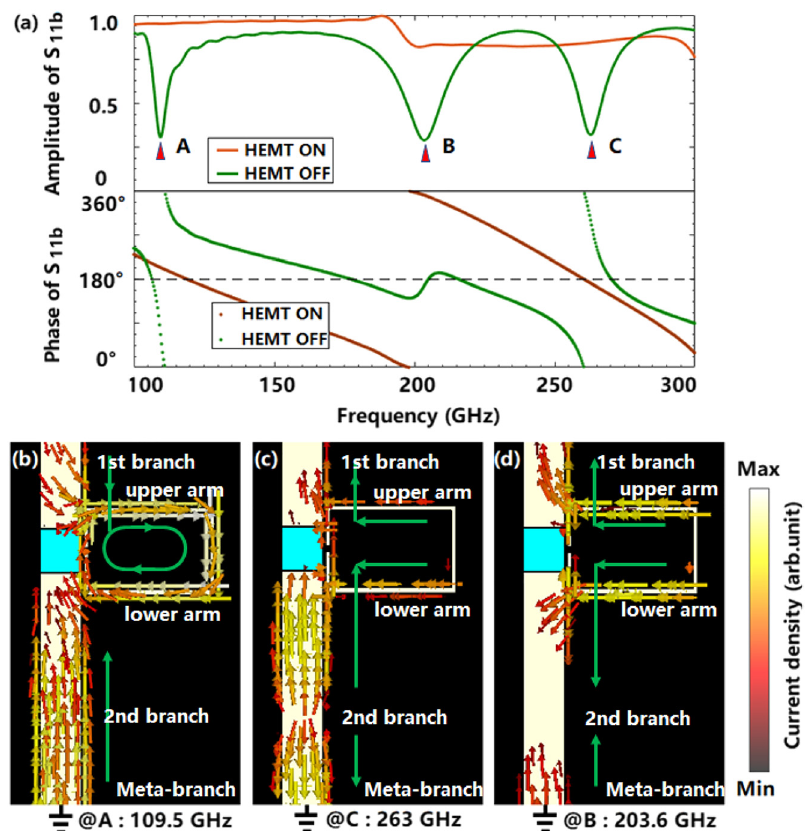
Figure 2: The spectra S 11b of meta-branch and the current distrbutions at the resonance points. (a) The spectra of the S 11 b for the InP-HEMT with voltage applied; (b) the current distribution at peak A; (c) the current distribution at peak C; and (d) the current distribution at peak